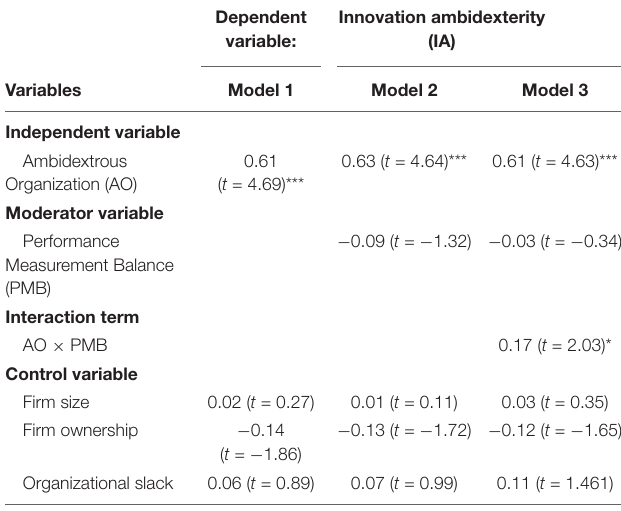
TABLE 6 | Results of the structural